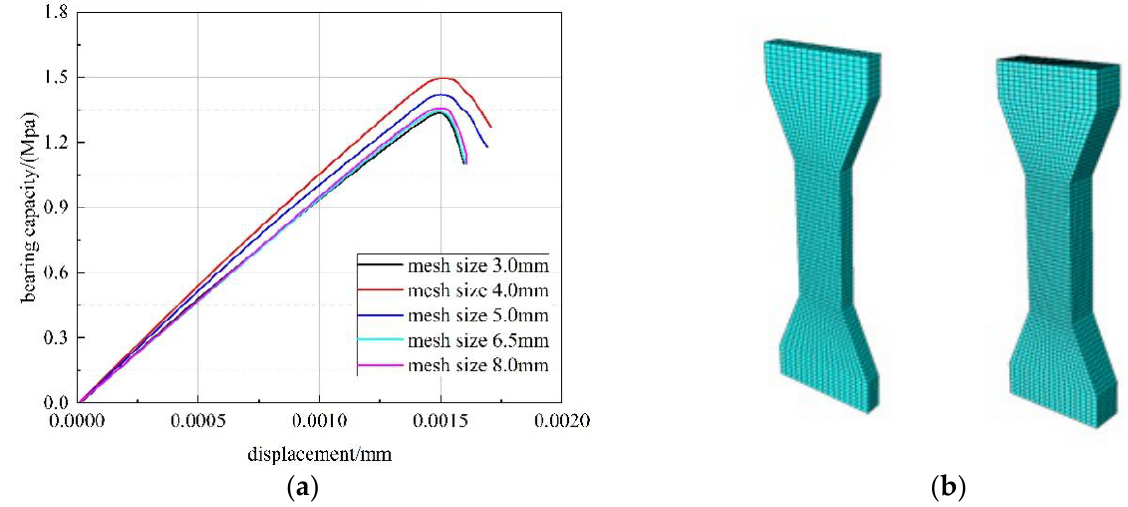
Figure 8. Geometric division of the axial tension model. ( a ) Specimen is printed horizontally; ( b ) Specimen is printed vertically.